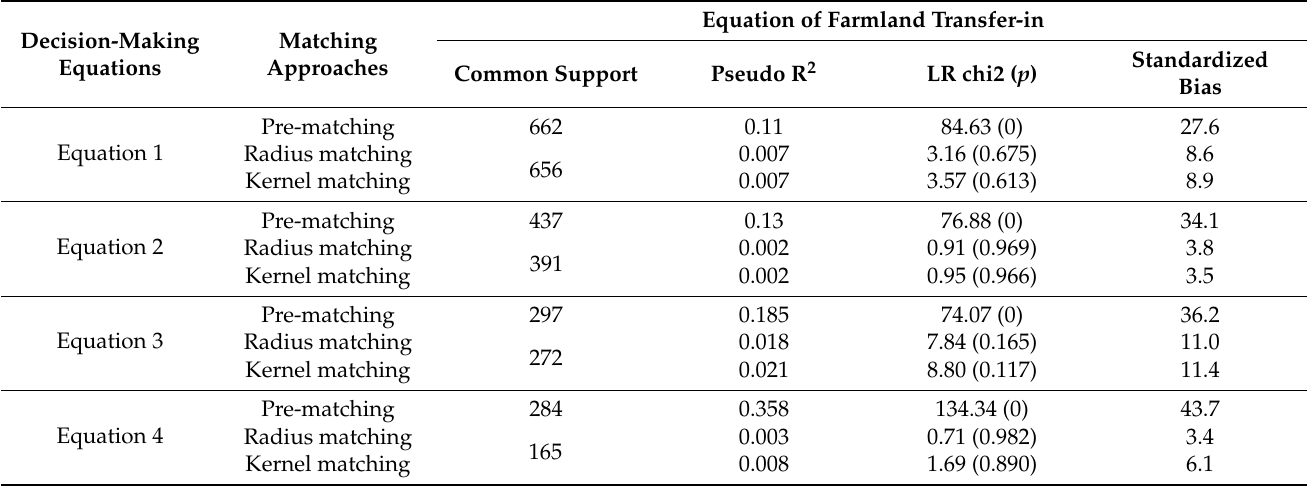
Table 3. Results of common support and data balancing estimation for farmland transfer-in equations. Decision-Making